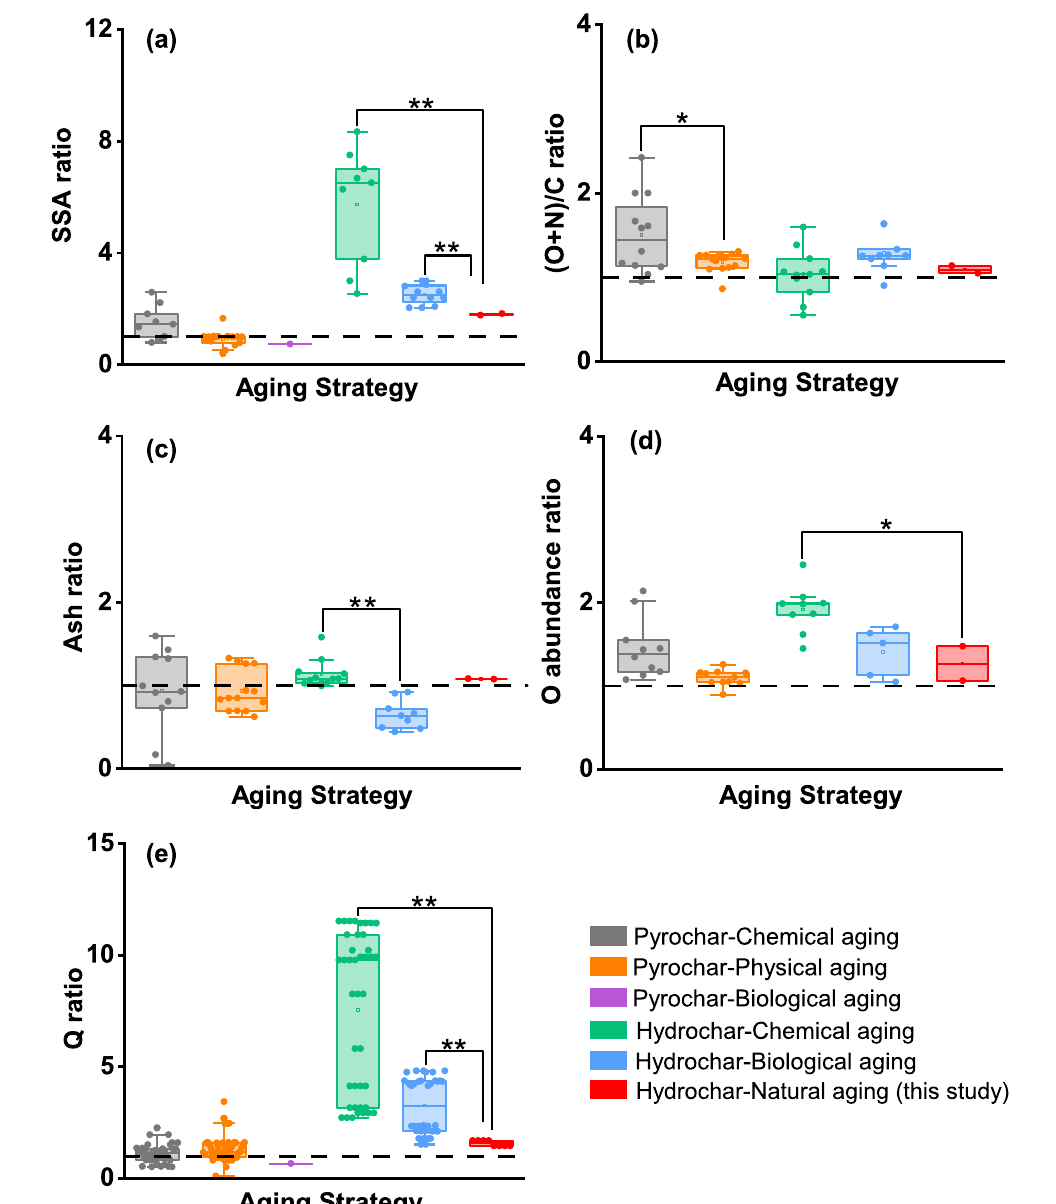
Fig.6 Box diagram distribution of the SSA ratio, (O + N)/C ratio, ash ratio, O abundance ratio, and heavy metal sorption capacity ratio (Q ratio) of hydrochar and pyrochar under different aging strategies. The dotted line represents that the corresponding parameters remain